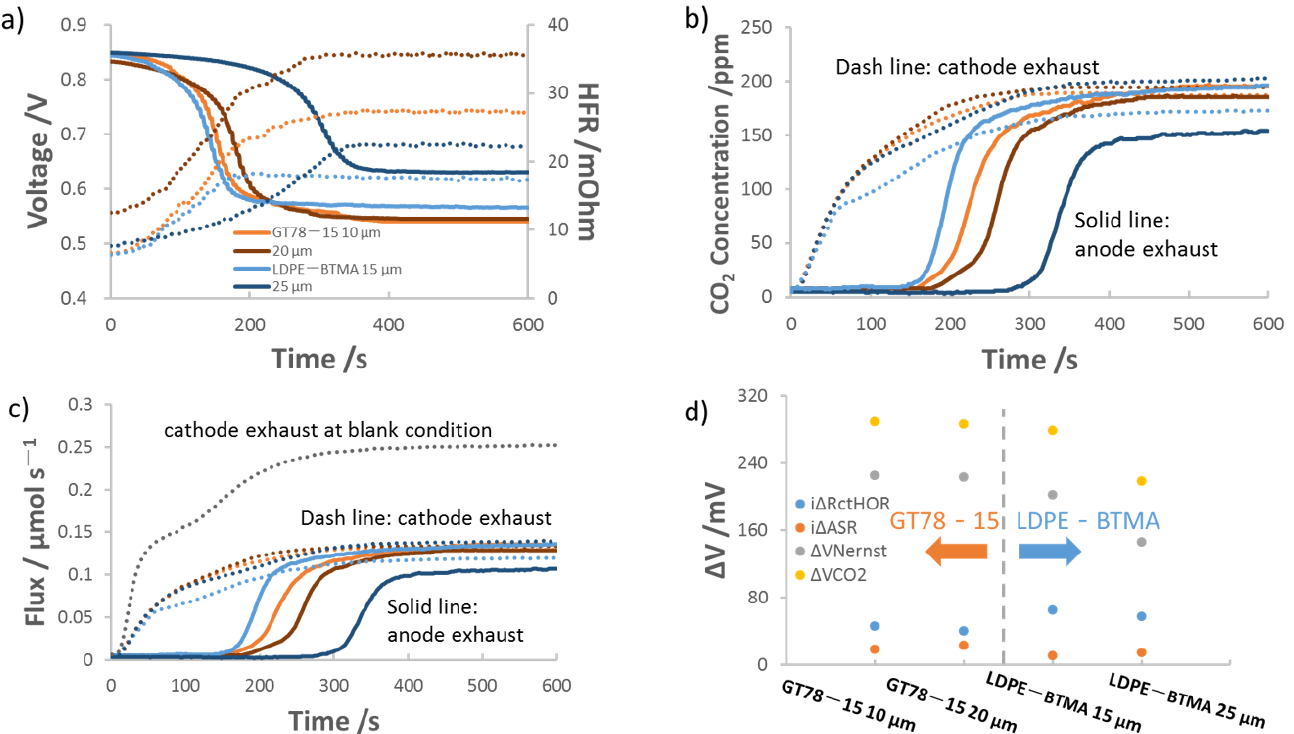
Figure 2. Effect of AEM thickness on anion exchange membrane fuel cell (AEMFC) carbonation and performance loss. The AEMFCs were operated at 0.2 A/cm 2 and 76 °C/76 °C/80 °C with 10 µm, 20 µm GT78-15 and 15 µm, 25 µm LDPE-BTMA AEMs, 400 ppm CO 2 fed to cathode at t = 0 s, and 1 L/min H 2 /O 2 flowrates. The anode catalyst loading was 0.5 mg Pt cm − 2 ± 0.1 mg Pt cm − 2 . The cathode catalyst loading was 0.6 mg Pt cm − 2 ± 0.1 mg Pt cm − 2 . ( a ) Voltage loss (solid lines) and high-frequency resistance (HFR) (dotted lines) following the introduction of CO 2 into the cathode; ( b ) concentration of CO 2 in the anode (solid lines) and cathode (dotted lines) effluent streams; ( c ) CO 2 flux leaving the anode and cathode; ( d ) deconvolution of the CO 2 -related voltage losses.